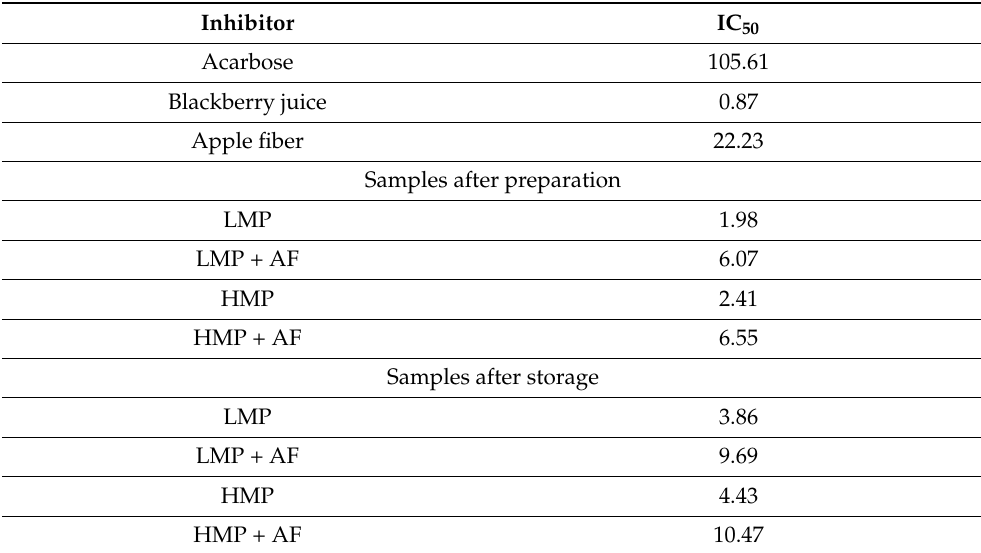
Table 5. Inhibition of α -glucosidase by acarbose, blackberry juice, and hydrogels (after preparation and after storage) expressed using IC 50 ( µ g